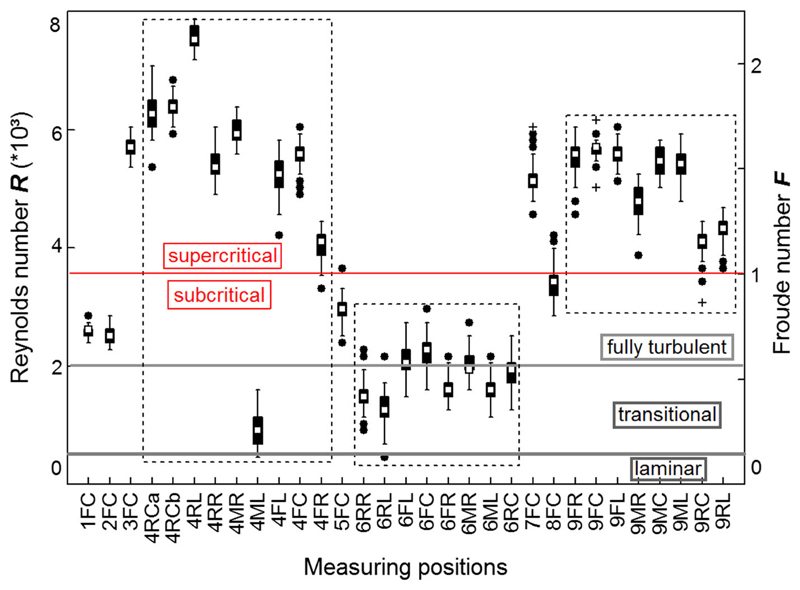
Box plots of Reynolds and Froude numbers (R, Fr) acting on fifth instar larvae (numbered 1 to 9) of Drusus biguttatus in the field with their longitudinal axis aligned with flow; showing the measuring positions of the propeller meter head (codes as in Fig. 1), and R and Fr, respectively (dimensionless). In addition to the measuring position at front center (FC), additional data were taken around larvae # 4, 6, and 9 (boxes with dotted lines). Gray lines divide R values in the laminar, transitional, and fully turbulent flow range, a red line divides Fr values in the sub- and supercritical range. Data for measuring positions 4FR, 5FC, and 8FCB indicate a transition of sub- to supercritical Froude numbers. White rectangles = means, black bars = 25/75% quartiles, whiskers = range without outliers, black dots = outliers, black crosses = extremes